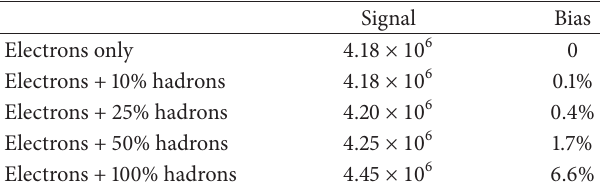
Table 2: Photonic electron yield in the 𝑚 𝑒 + 𝑒 − < 0.2 GeV/ 𝑐 2 mass range for various hadron contamination levels. The statistical uncer- tainty is 0.05%. The bias is defined as the relative difference between the observed yield and the signal in the pure electron